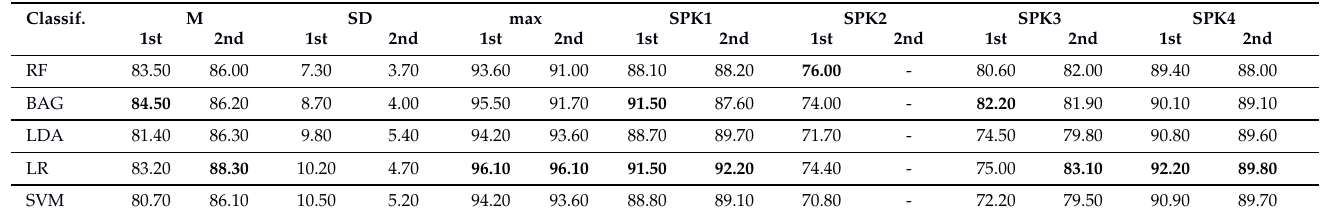
Table 3. Mean (M), standard deviation (SD), and maximum (max) accuracy value for a specific k-fold iteration, and average recognition scores per speaker obtained for the different classifiers. For each column the highest recognition score is presented in bold face. All metrics were calculated and present values that are respective to a particular acquisition